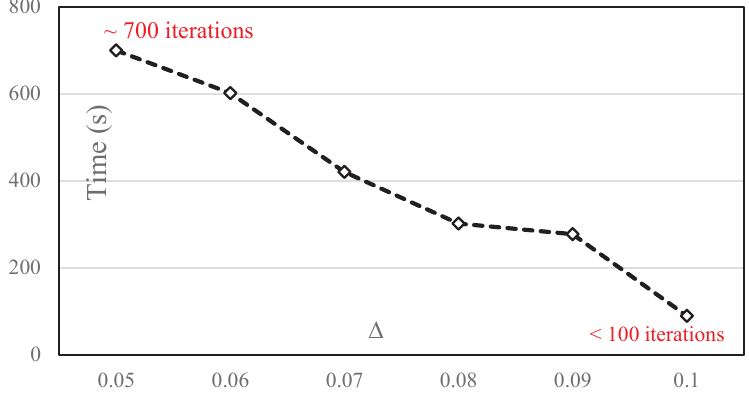
Figure 5. ∆ and Computational Time.